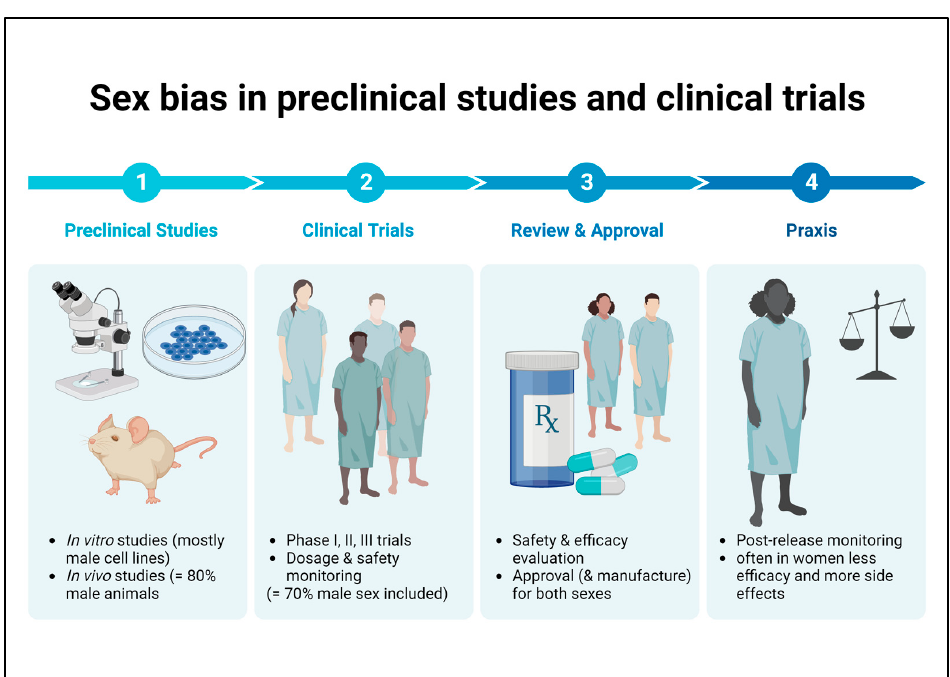
Figure 2. Sex bias in basic preclinical research and clinical trials. Male bias in animal studies as well as in human clinical trials may lead to reduced efficacy or harmful side effects in female patients that remain undetected until the post-marketing observation phase.